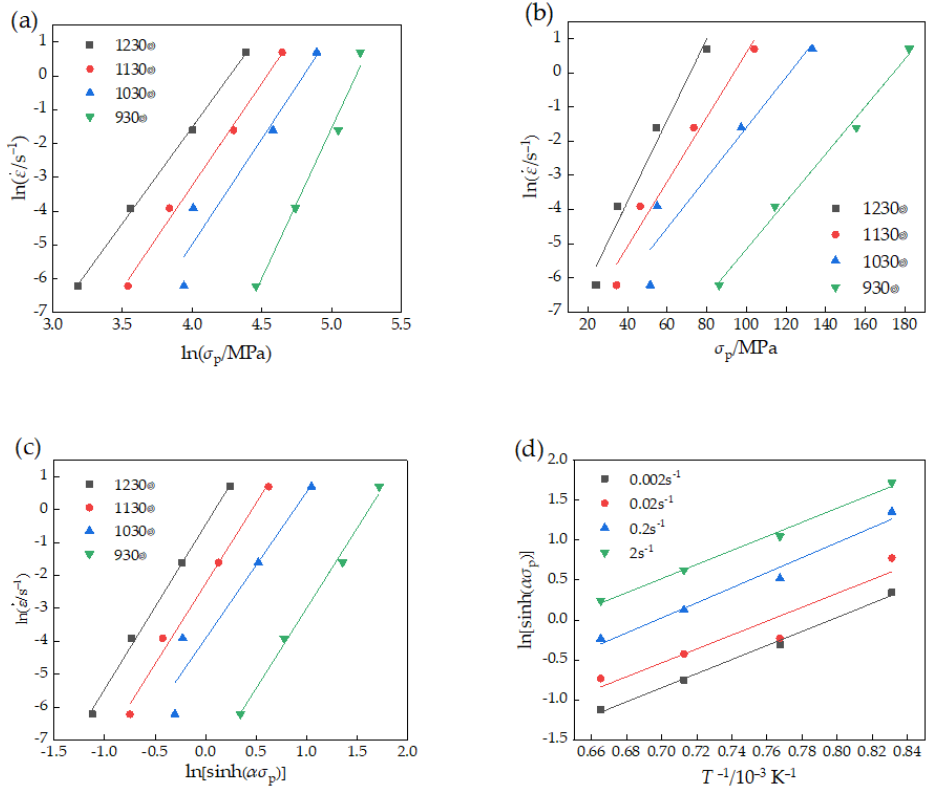
. . . ε –ln σ p ; ( b ) ln ε – σ p ; ( c ) ln ε –ln[sinh( ασ p )]; ( d ) 1000/ T –